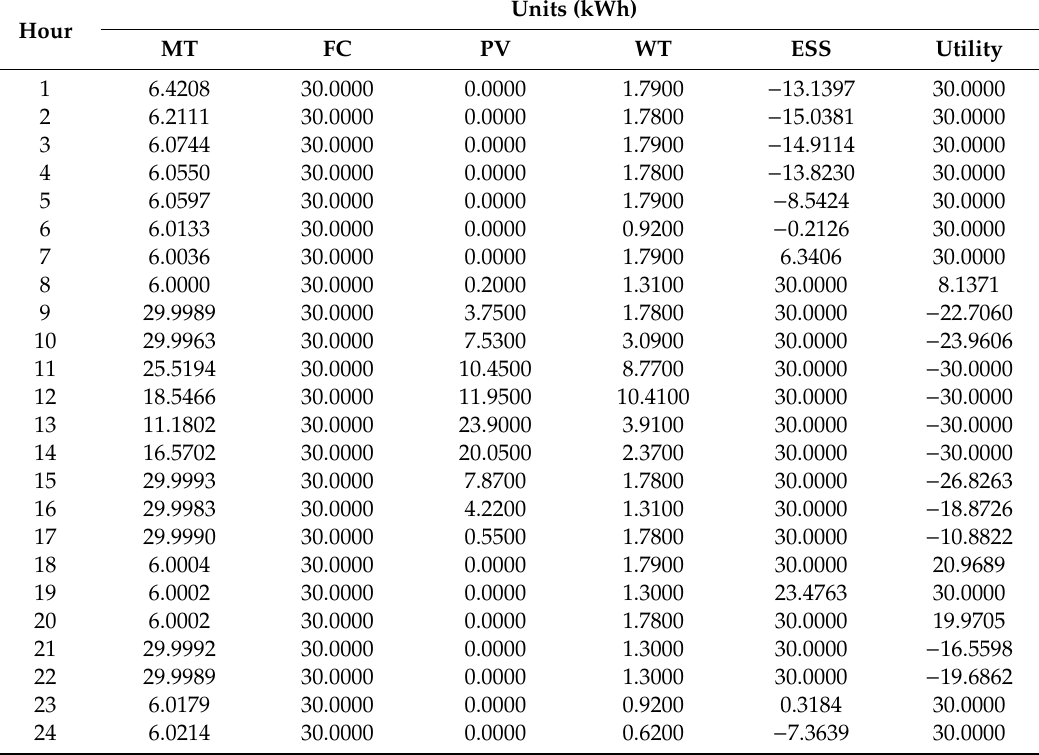
Table 8. Optimal power scheduling ( β =